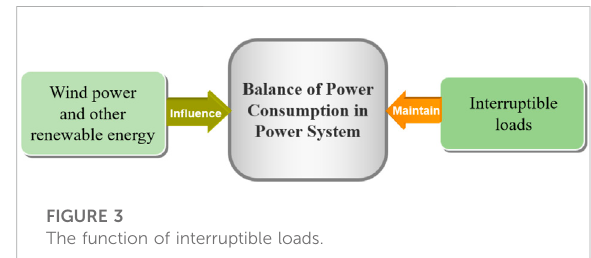
FIGURE 3 The function of interruptible